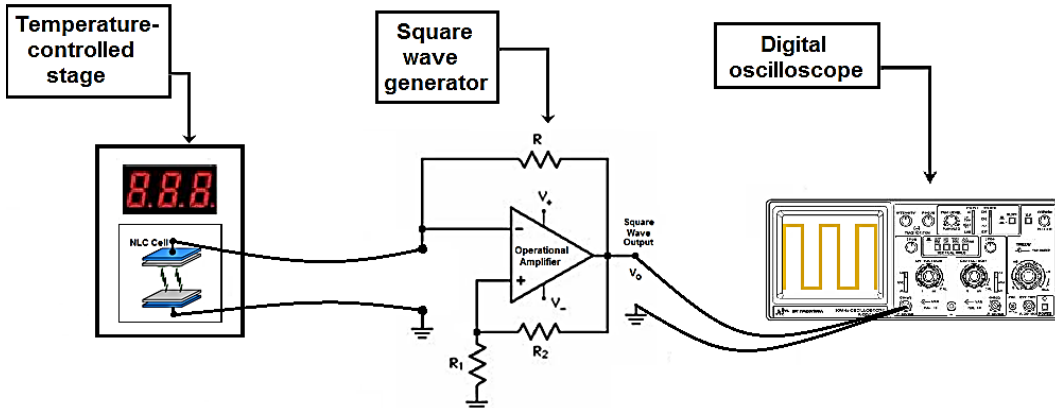
Figure 6. Experimental setup for the temperature-frequency converter.